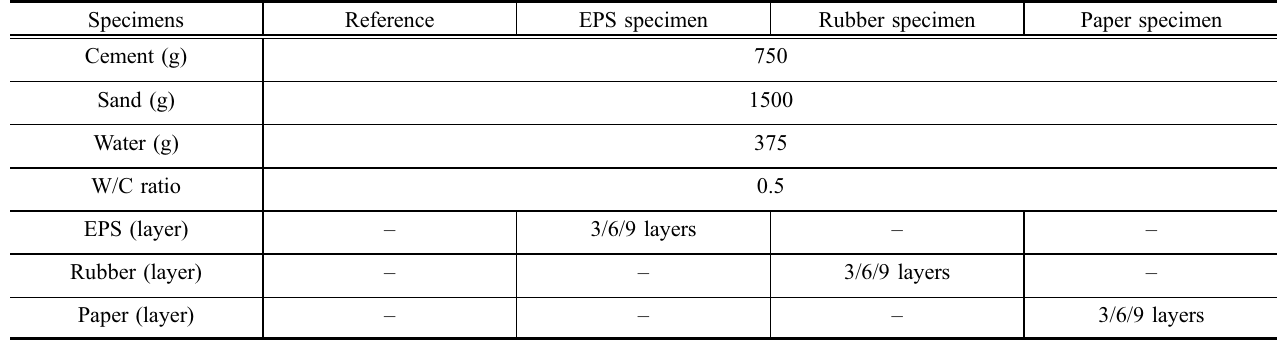
Fig. 2 Insulating specimens with different anisotropic insulation materials. Table 2 Mix design for the mortar specimens in Fig.